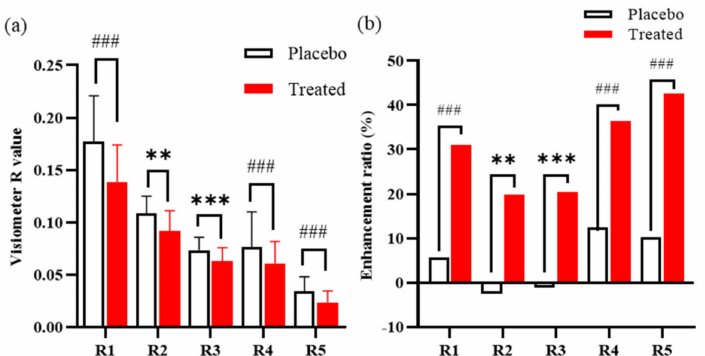
Figure 7. Comparison of ( a ) visiometer R values and ( b ) their enhancement ratio between placebo and treated groups after 8 weeks treatment with a cream including I. indigotica leaf extract. Enhancement ratios were calculated as the difference of R value between time 0 and 8 weeks divided by the R value at 8 weeks. ** and *** indicate significant differences at 0.01 and 0.001 significance level, respectively, by the results of repeated-measures analysis of variance when the normality was proved by Ryan–Joiner normality test. ### indicates a significant difference at 0.001 significance level by the Friedman test when the normality was rejected by Ryan–Joiner normality